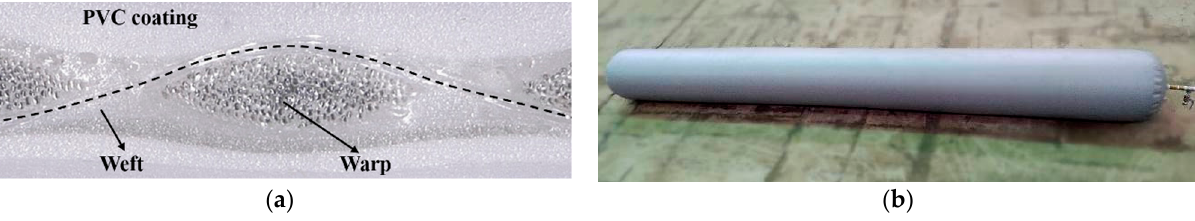
Figure 2. ( a ) Typical configuration of the fabric membrane; ( b ) Photo of the inflated sample.